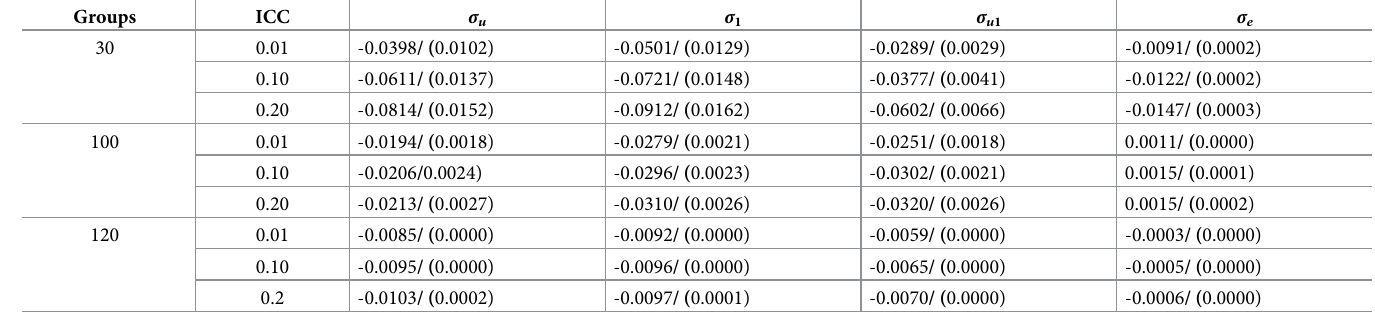
Table 5. Average relative parameter bias of the random effect estimates obtained for lognormal distribution data (First = REML estimation procedure, Second = Bootstrap estimates are enclosed in parenthesis). Groups